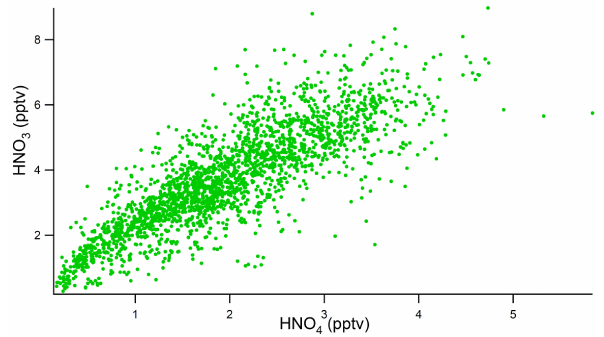
Figure 2. Nitric acid (HNO 3 ) vs. peroxynitric acid (HO 2 NO 2 ); hourly averages of measurements made from 24 May to 18 Septem- ber